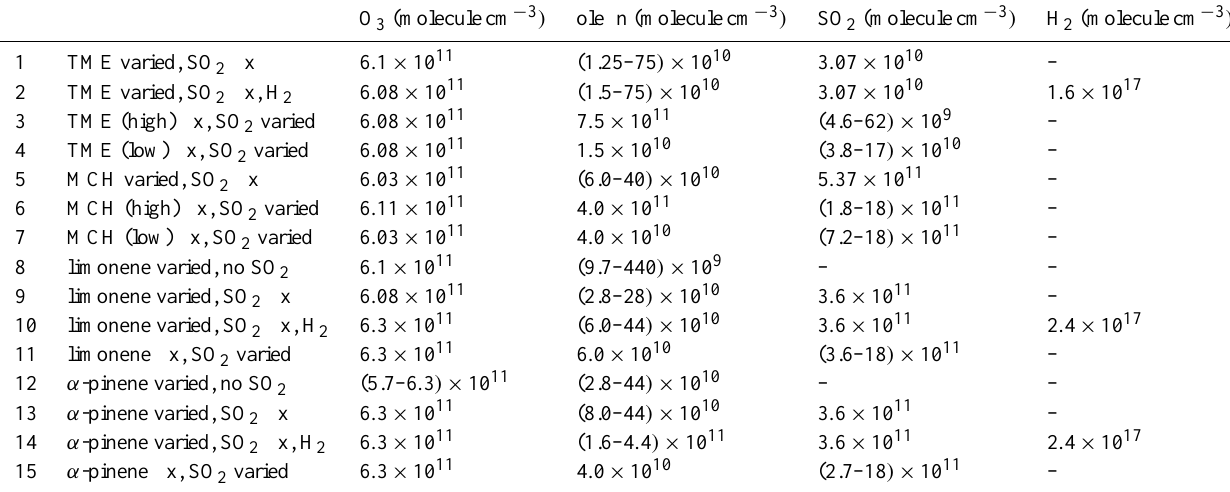
Table 1. Reactant concentrations used in ozonolysis experiments in synthetic air, RH = 22%, bulk residence time =